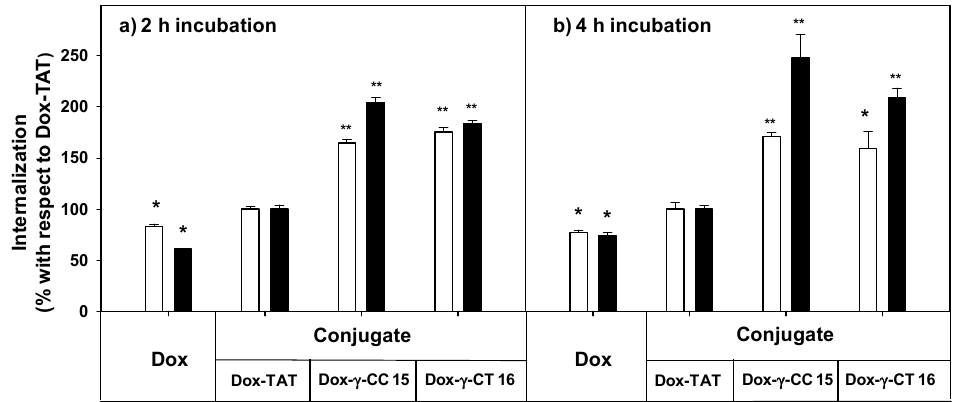
Figure 9. Uptake of free- and peptide-conjugated doxorubicin by Leishmania donovani promastigotes at ( a ) 2 h incubation, ( b ) 4 h incubation. Doxorubicin uptake was quantified by flow cytometry using the doxorubicin fluorescence setting ( λ EXC = 488 nm; λ EM = 515 nm) after incubation of the parasites (20 × 10 6 cells / mL, 26 ◦ C in HBSS-Glc) for ( a ) 2 h, and ( b ) 4 h. Data were represented as percentage ± SD with respect to the uptake of the Dox-TAT conjugate. Reagent concentration: 5 µ M (white columns); 10 µ M (black columns). Samples were made by duplicate ( p ≤ 0.05, (*); p ≤ 0.01, (**)). Dox: doxorubicin; HBSS-Glc: Hanks buffered saline solution and glucose.